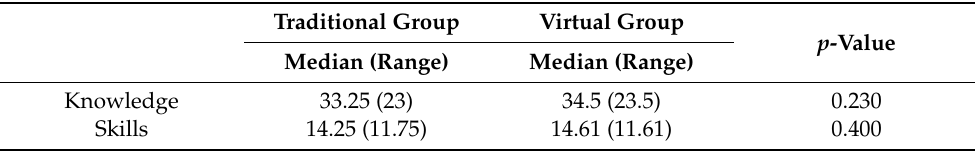
Table 3. Comparisons between level of knowledge and skills among students.